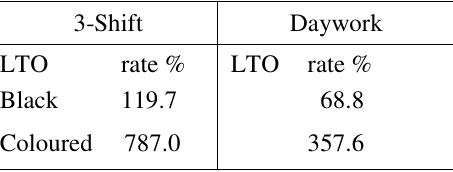
LABOUR TURNOVER RATES (PER CENT PER ANNUM) FOR 3-SHIFT AND DAYWORKERS: BLACK AND COLOURED MALES, JANUARY-MARCH